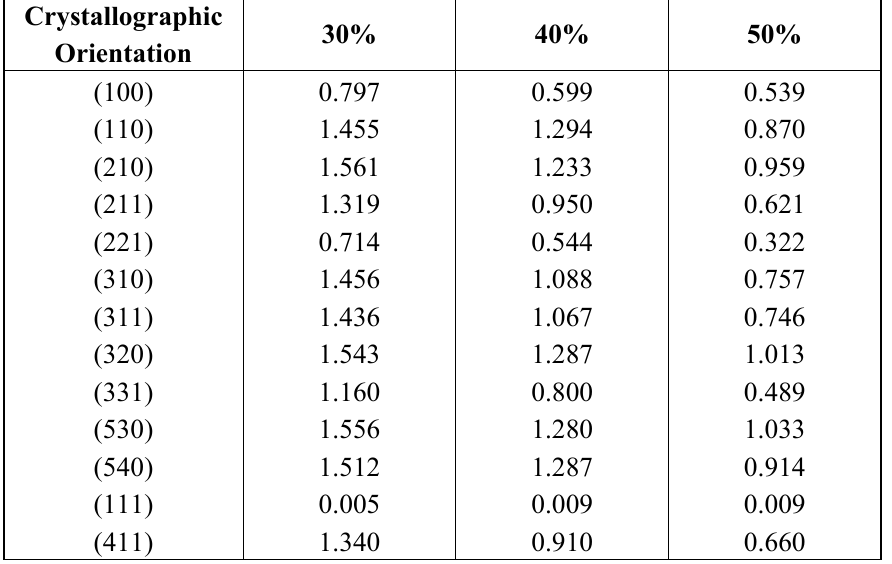
Table 1. Etching rates of silicon at different KOH concentrations at 70 ºC